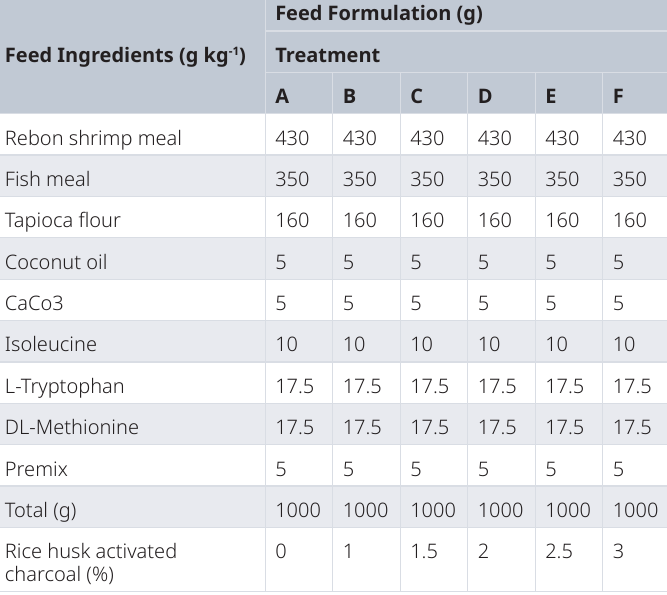
Feed Ingredients (g kg -1